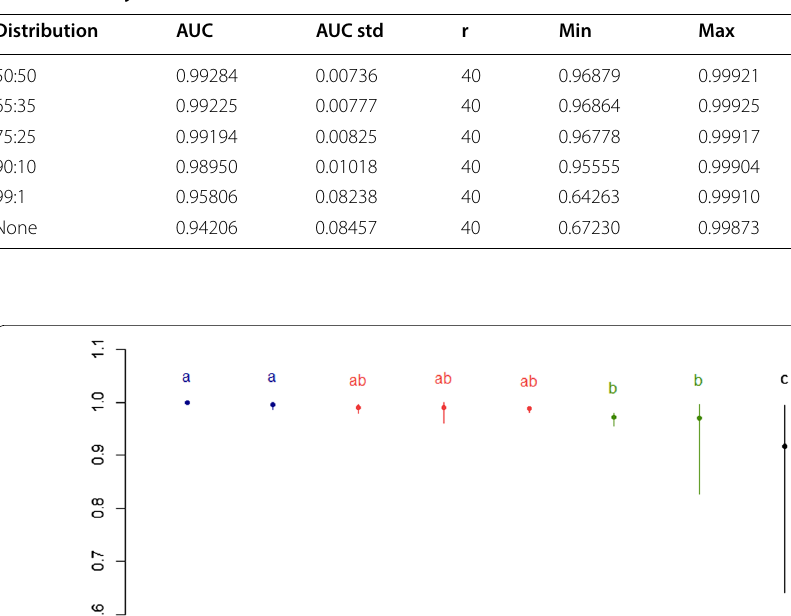
Table 5 Tukey’s HSD class distribution results